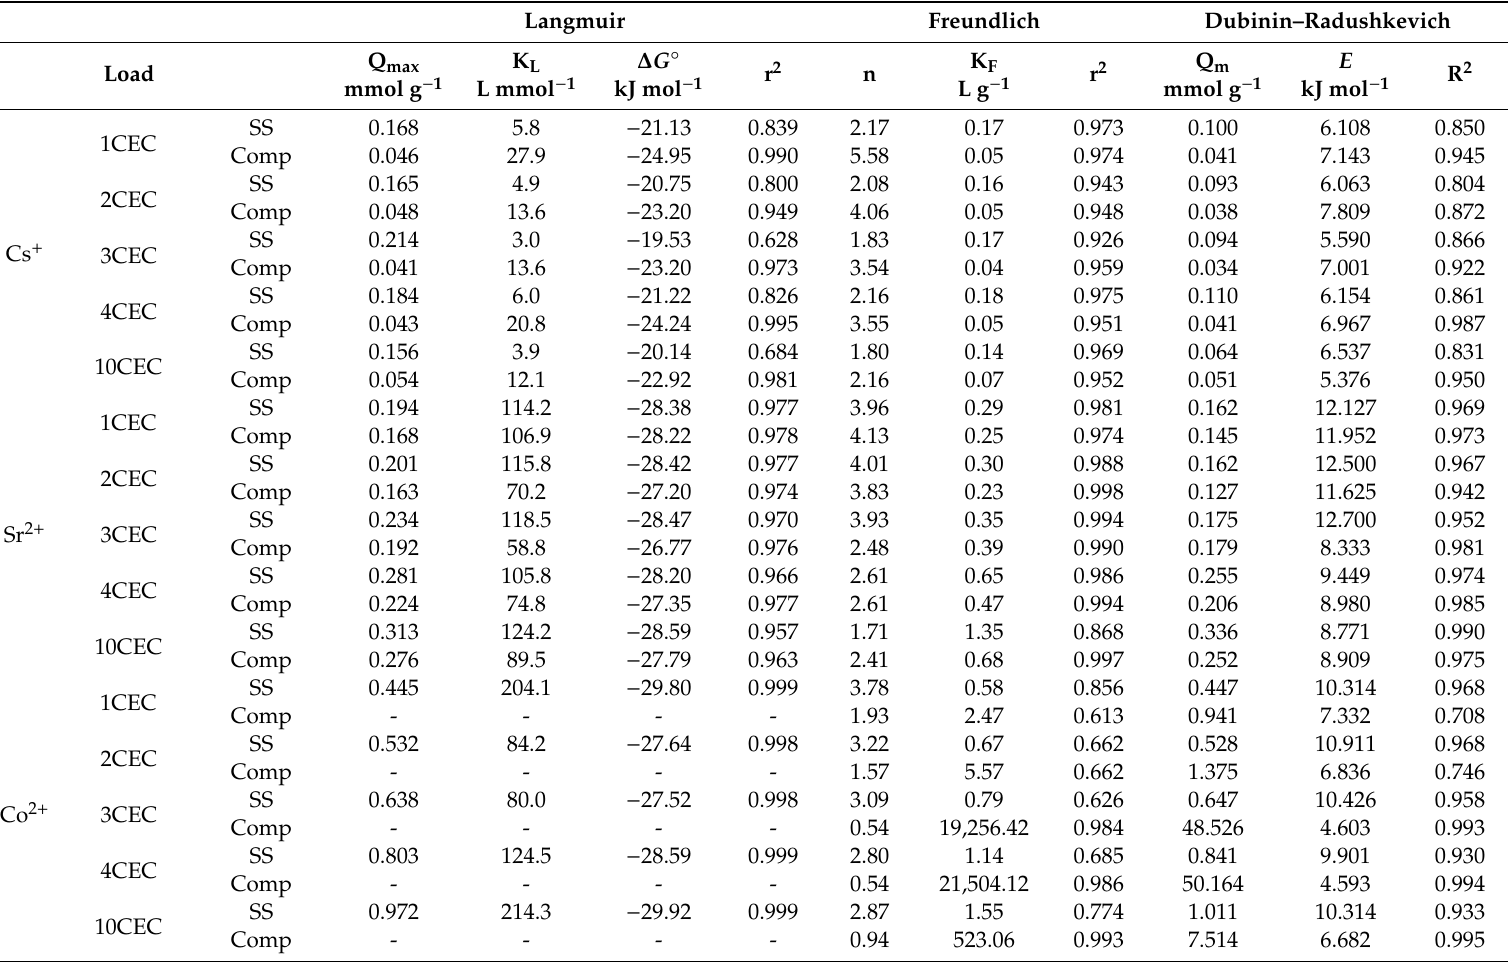
Table 2. Single-solute (SS) and competitive (Comp) adsorption model parameters derived from Langmuir, Freundlich, and DR equations for the adsorption of Co 2 + , Cs + and Sr 2 + onto LAP-APTES for di ff erent loads of